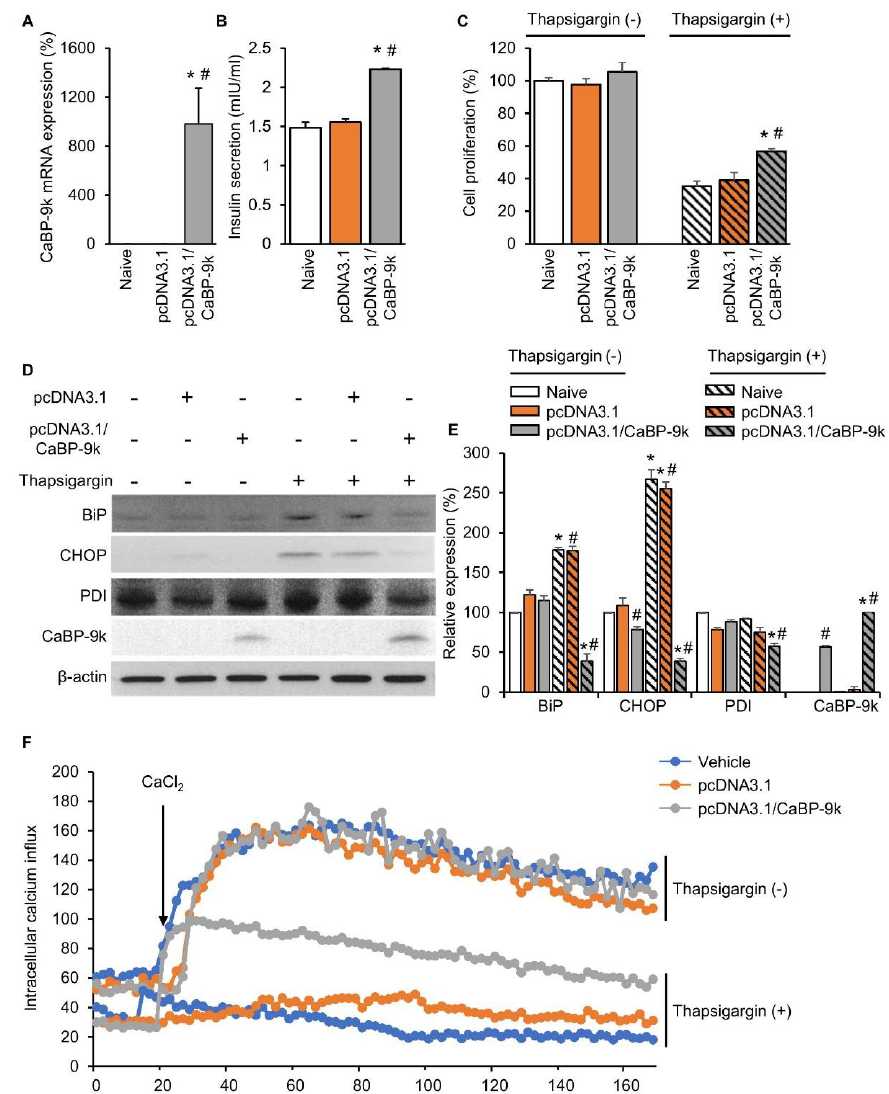
Figure 6. CaBP-9k overexpression recovered insulin secretion and pancreatic beta cell survival. The CaBP-9k expression was successfully induced by overexpression vector pcDNA 3.1( + ) ( A ). Overexpressed CaBP-9k increased insulin secretion ( B ), cell survival rate ( C ), and alleviation of ER stress marker expression ( D , E ). Intracellular calcium influx measurement with confocal microscopy ( F ). Values are expressed means ± SDs; * p < 0.05 versus Naive; # p < 0.05 versus